Question: Describe this figure in one sentence.
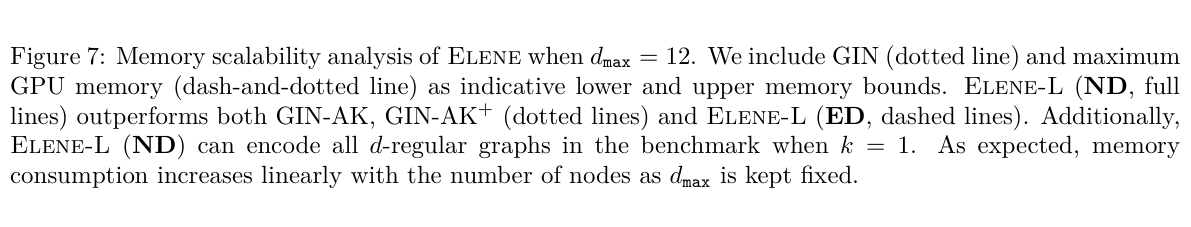
Answer: Memory scalability analysis of Elene when dmax = 12. We include GIN (dotted line) and maximum GPU memory (dash-and-dotted line) as indicative lower and upper memory bounds. Elene-L (ND, full lines) outperforms both GIN-AK, GIN-AK+ (dotted lines) and Elene-L (ED, dashed lines). Additionally, Elene-L (ND) can encode all d-regular graphs in the benchmark when k = 1. As expected, memory consumption increases linearly with the number of nodes as dmax is kept fixed.